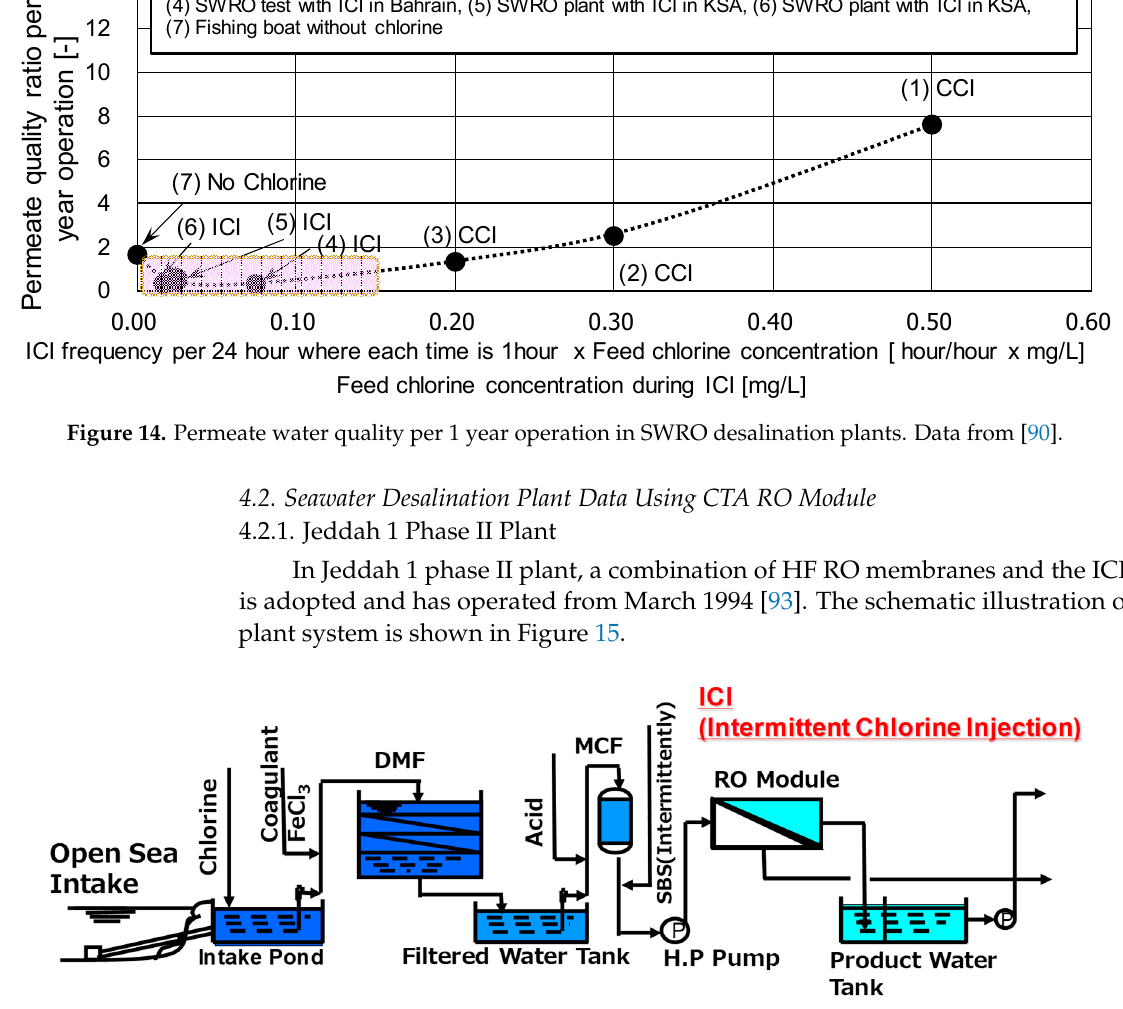
Figure 15. Seawater RO desalination system in Jeddah 1 phase II plant.